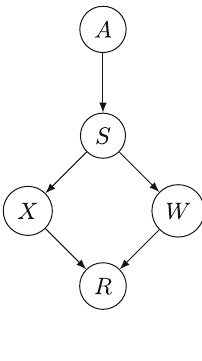
Figure 8: SCM M and its associated graph G pertaining to Example